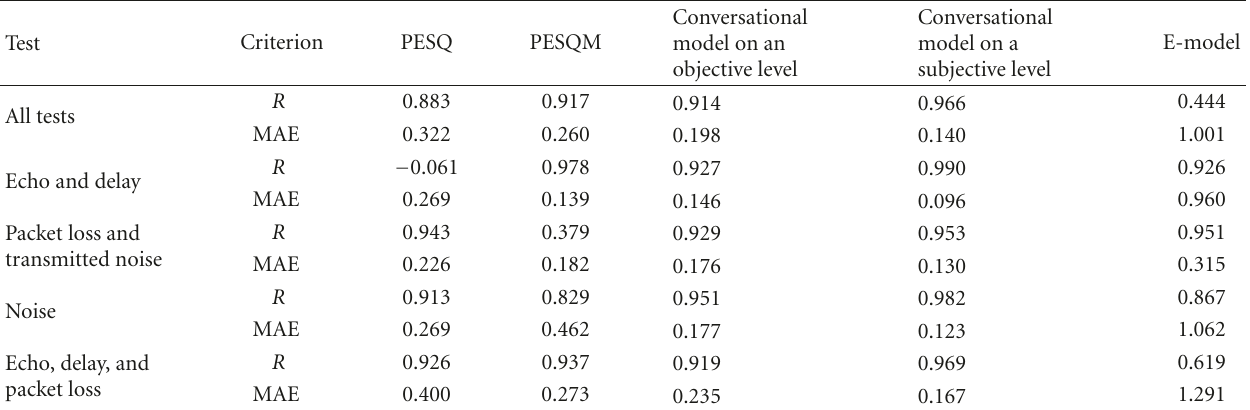
Table 7: Final performance of PESQ, of PESQM, of our conversational model (on an objective level and on a subjective level), and of the E-model for each test. R = correlation coe ffi cient, MAE = mean absolute